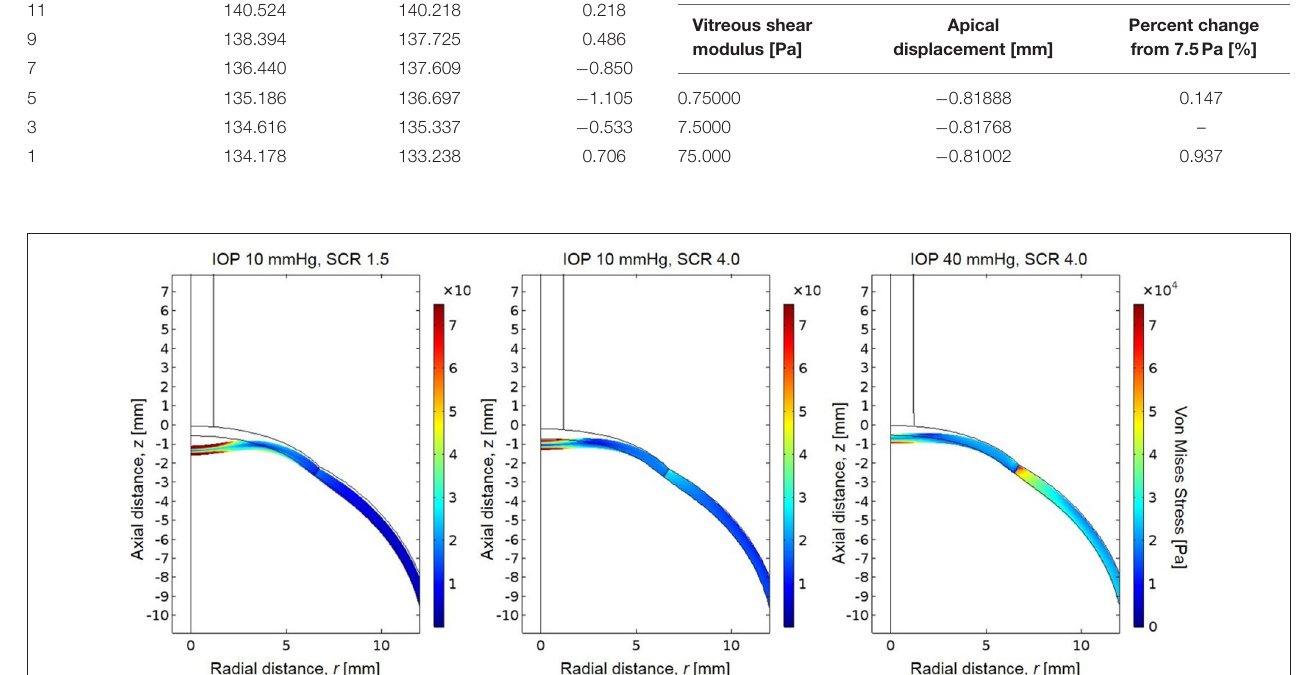
Frontiers in Bioengineering and Biotechnology |